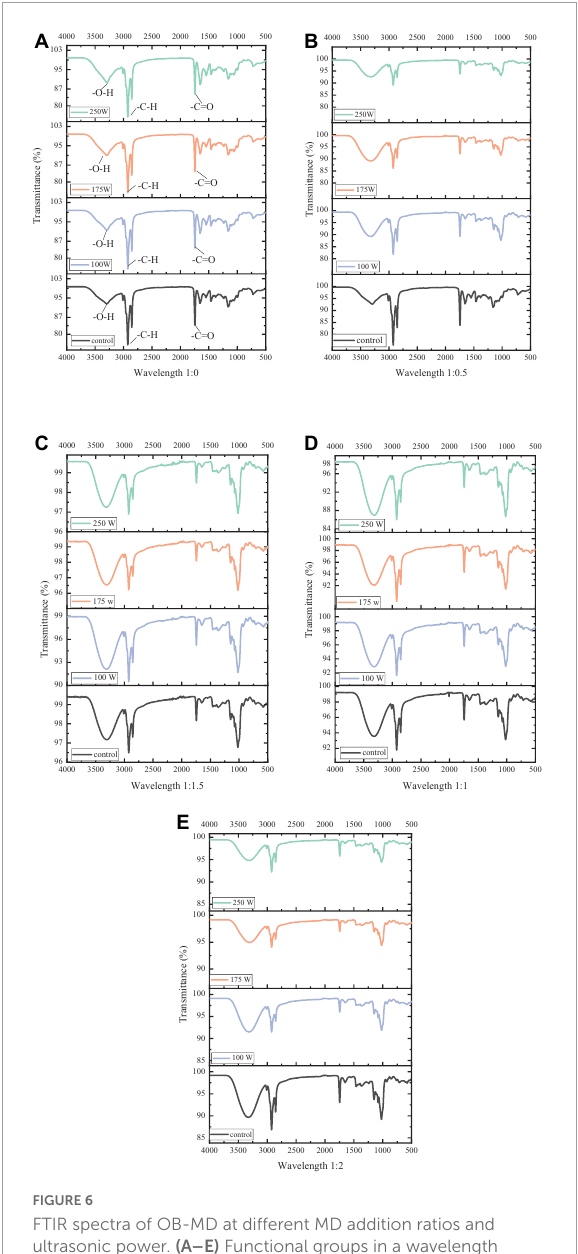
FIGURE6 FTIR spectra of OB-MD at different MD addition ratios and ultrasonic power. (A–E) Functional groups in a wavelength